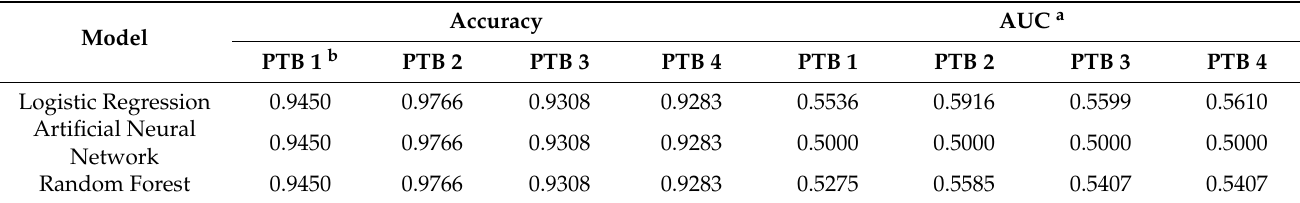
Table 2. Model performance.